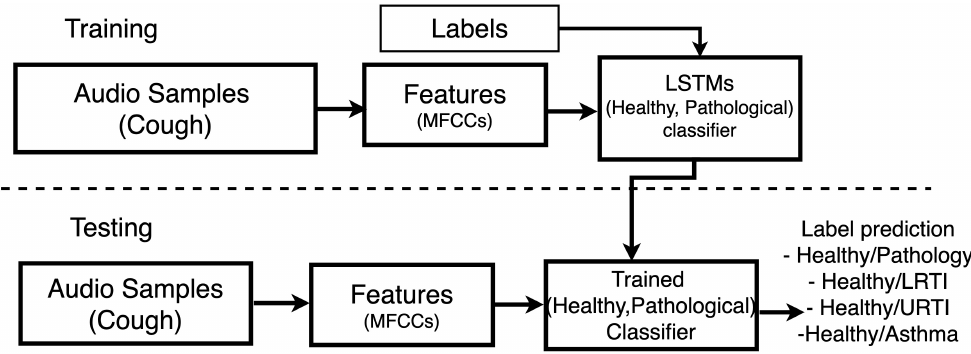
Figure 2. Experimental Methodology followed in our